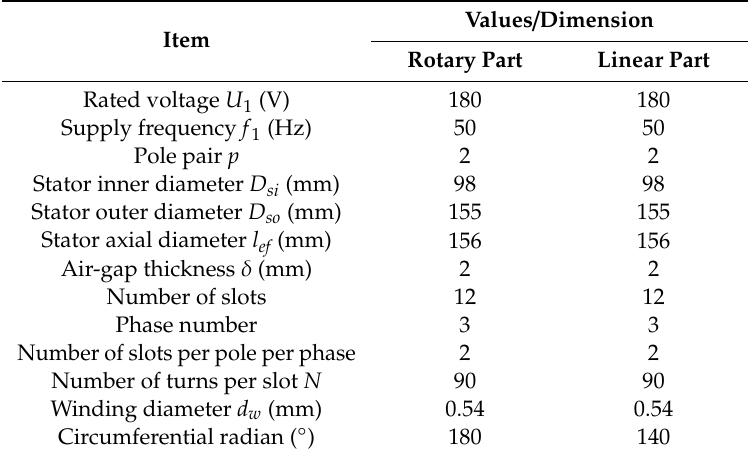
Figure 1. Structure of 2DoFDDIM: ( a ) Rotary motion arc-shaped armature; ( b ) Linear motion arc-shaped armature; ( c ) SSR; ( d ) Assembly of the 2DoFDDIM. Table 1. Structure Parameters of 2DoFDDIM.